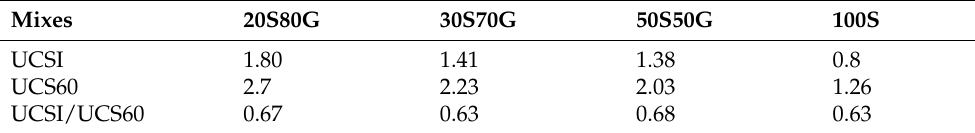
Table 6. Water immersion effect on UCS.